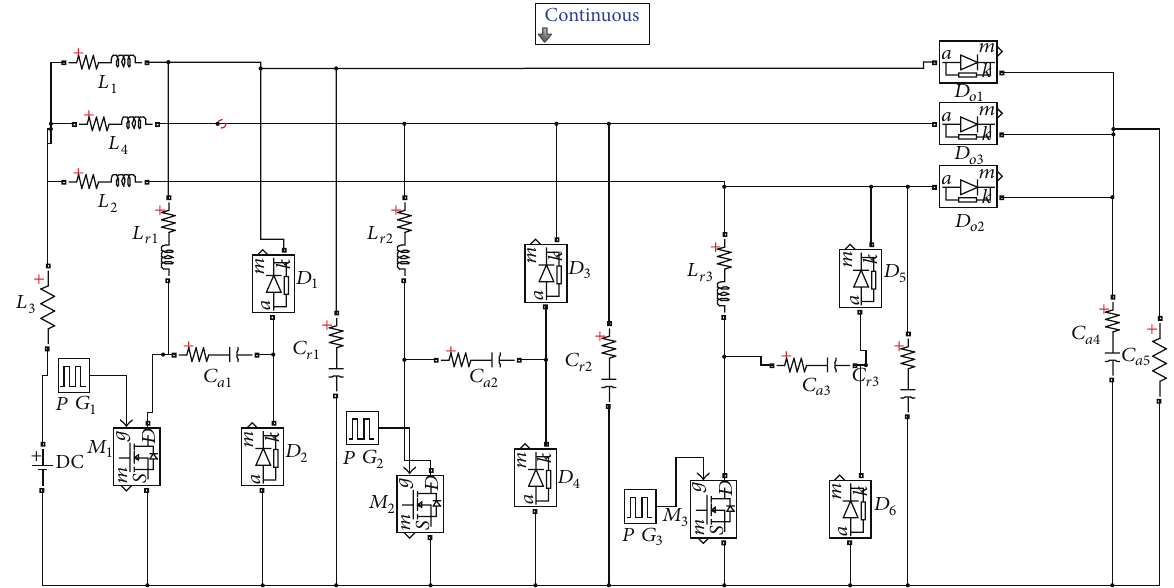
Figure 15: Simulation circuit of three-stage soft-switching boost converter.